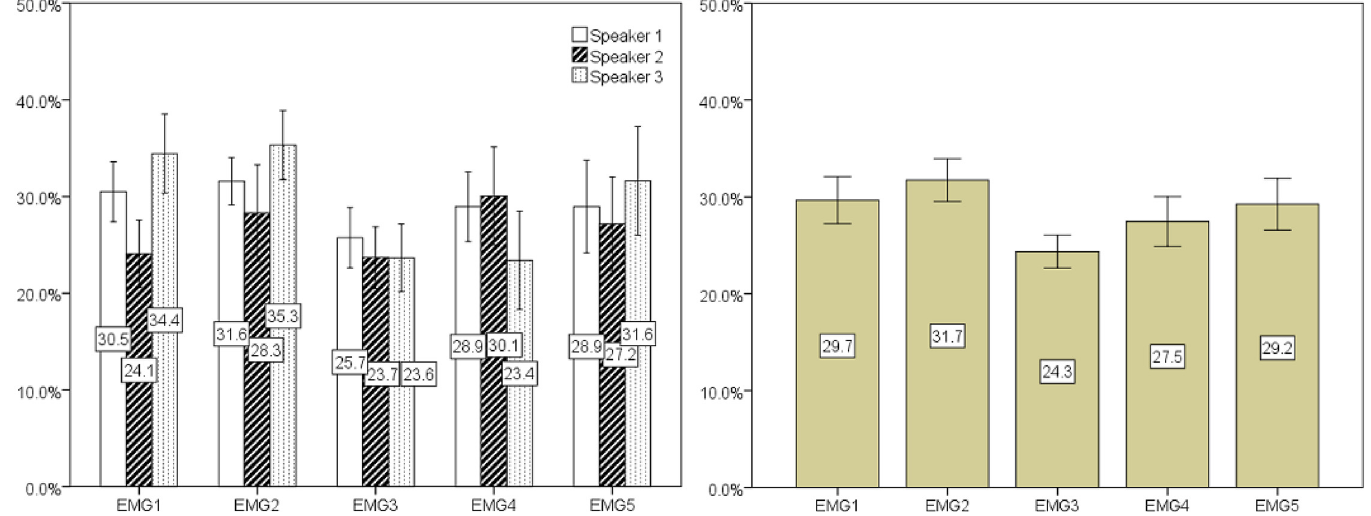
Fig 13. The graph on the left shows the mean error rate for each speaker clustered by EMG channel. The graph on the right shows the mean of the error rates from each speaker also clustered by EMG channel. Error bars show a 95% confidence interval.